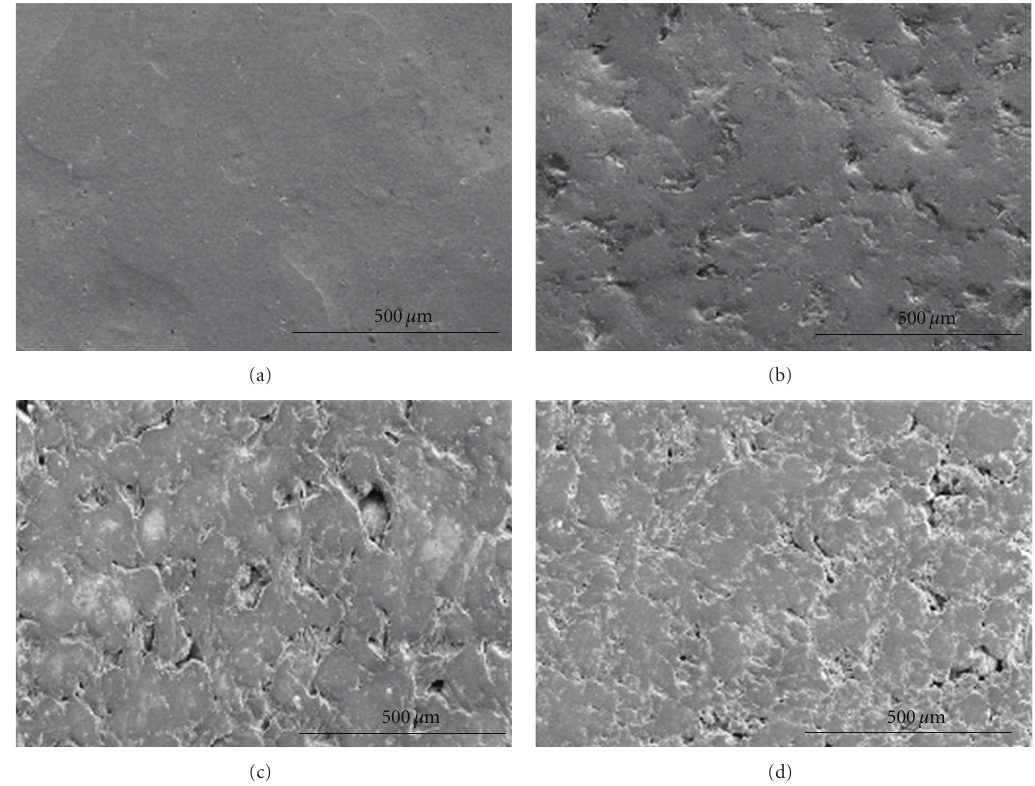
Figure 2: SEM images showing the surfaces of the WG layer with 30wt.% of plasticizer containing glycerol and oleic acid in the mass proportions: (a) 100: 0, (b) 75 :25, (c) 50:50, and (d) 25:75.